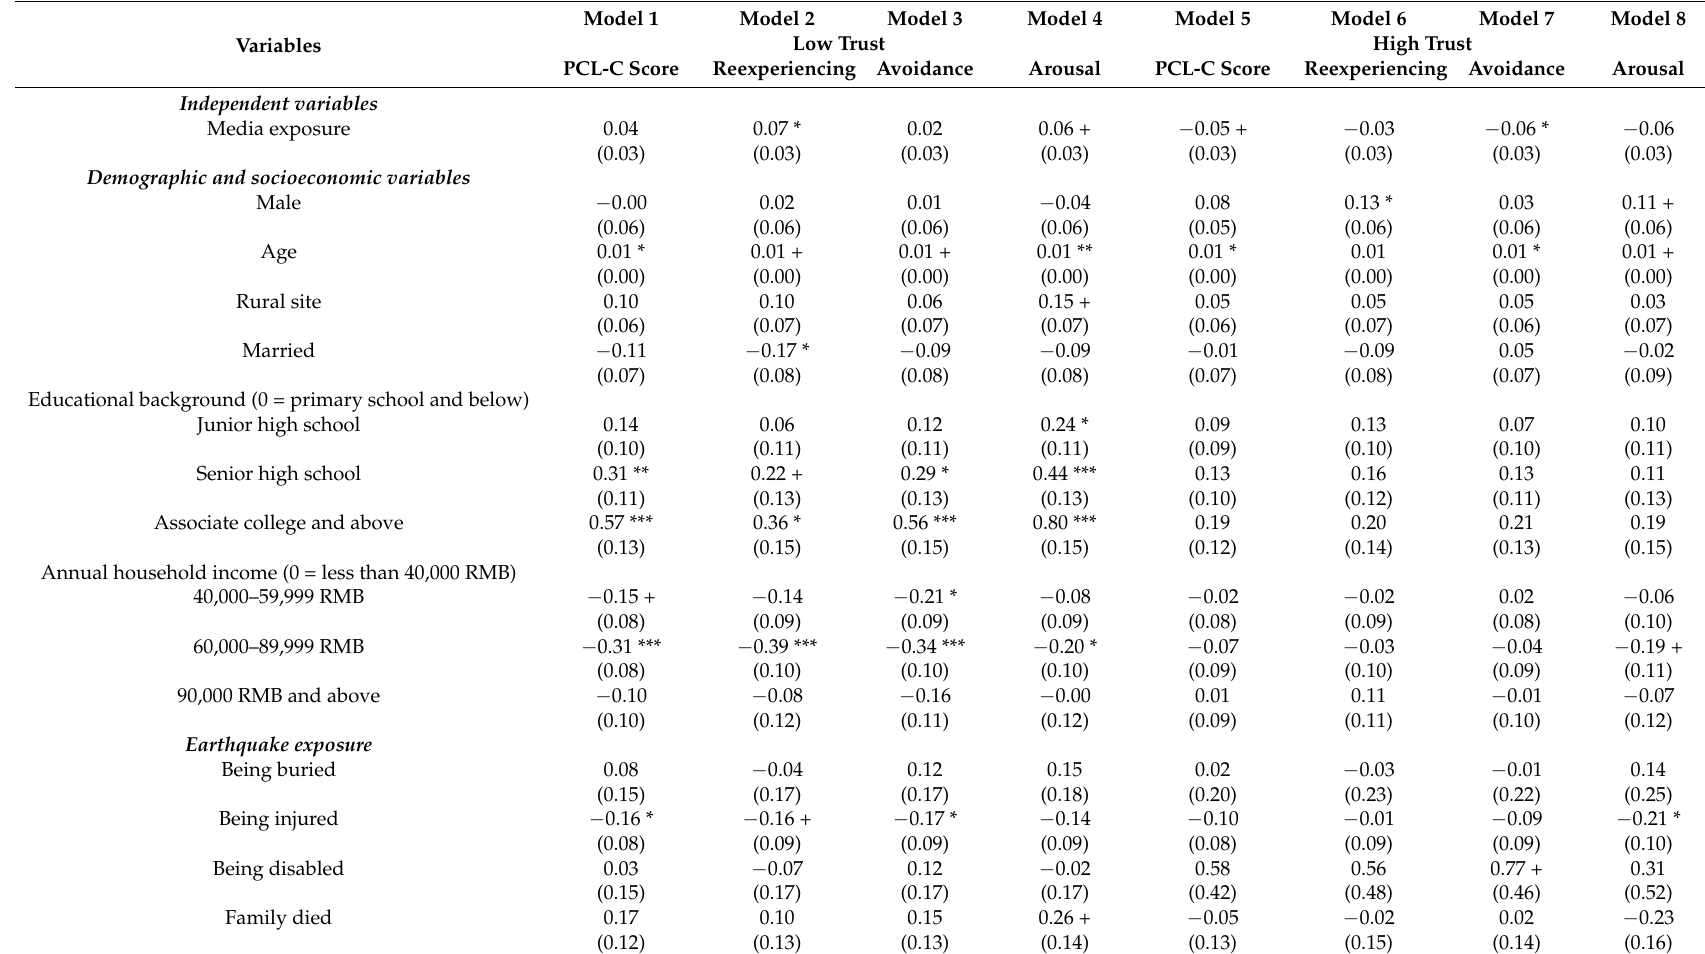
Table A1. Tobit model of predicting PTSD symptoms for low trust and high trust participants,